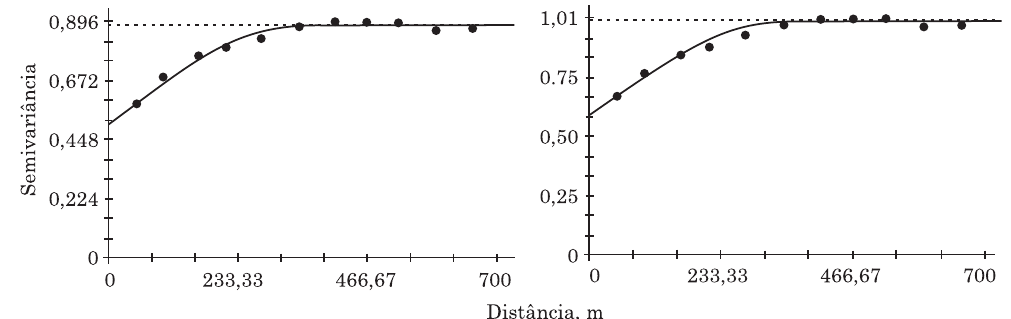
Figura 3. Variogramas do fósforo lábil: modelo experimental (•) e modelo teórico (—) dos dados amostrais com transformação logarítmica (a) e com transformação normal